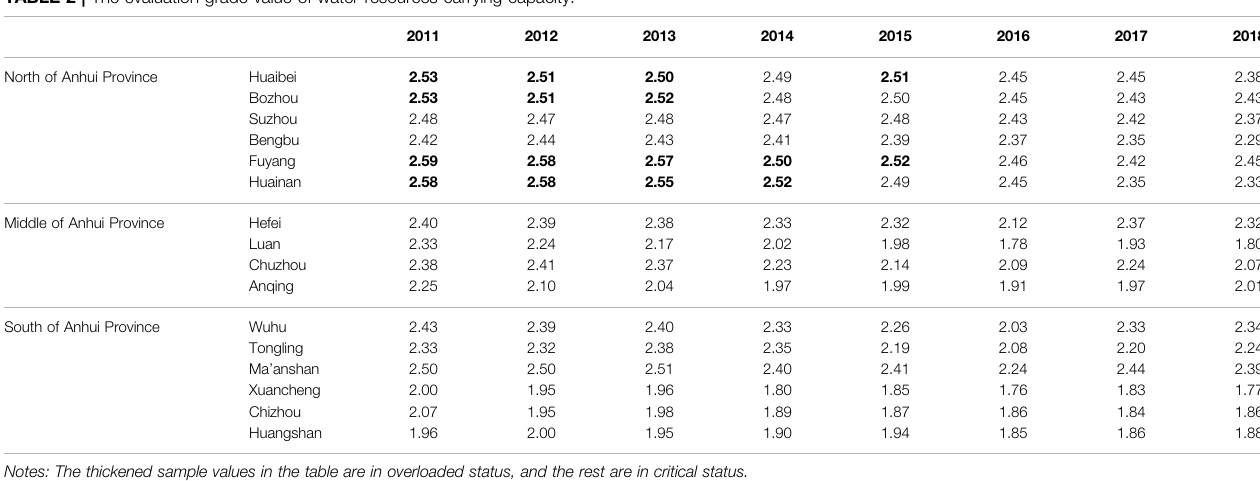
TABLE 2 | The evaluation grade value of water resources carrying capacity.